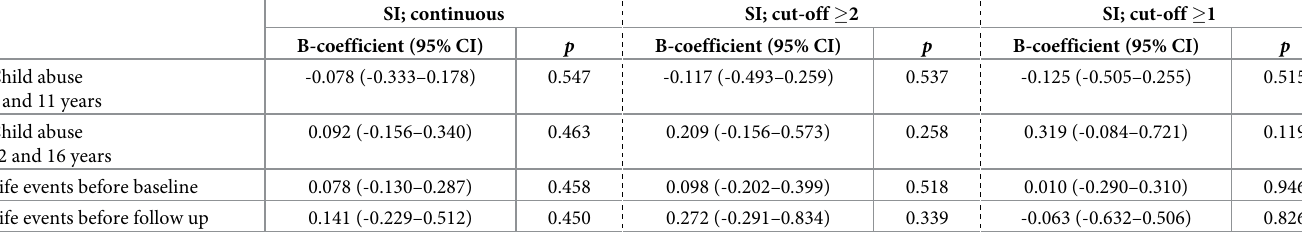
Table 4. Main effect of childhood trauma and life events on white noise speech